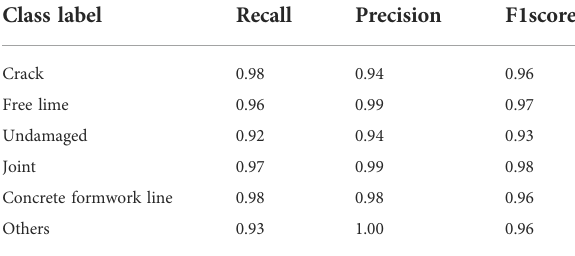
TABLE 2 Classi fi cation results for each